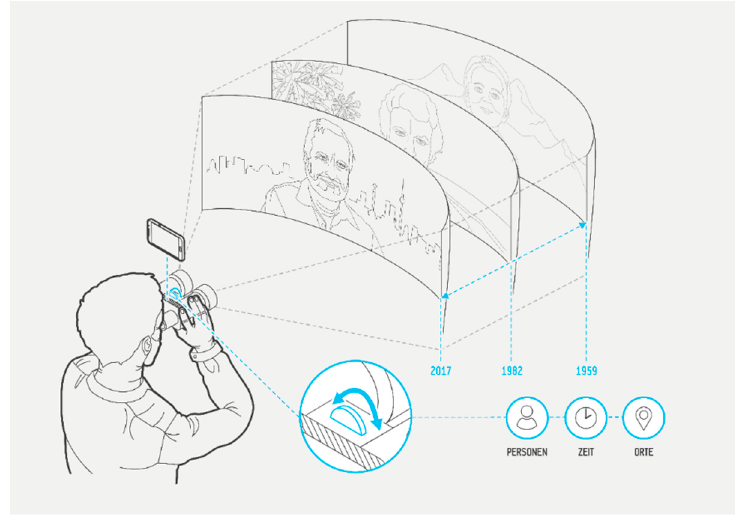
Figure 7 . Time-travel concept in the “Binoculars”.